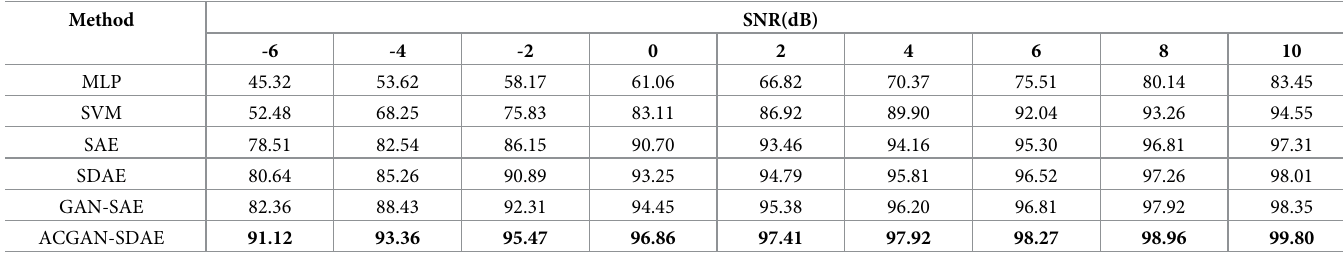
Table 4. Diagnosis accuracy of six diagnosis models under different SNRs